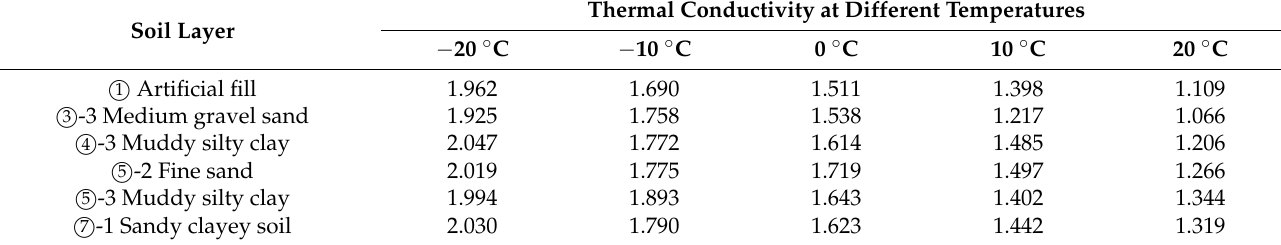
Table 3. Thermal conductivity of soil layer (W/(m ·